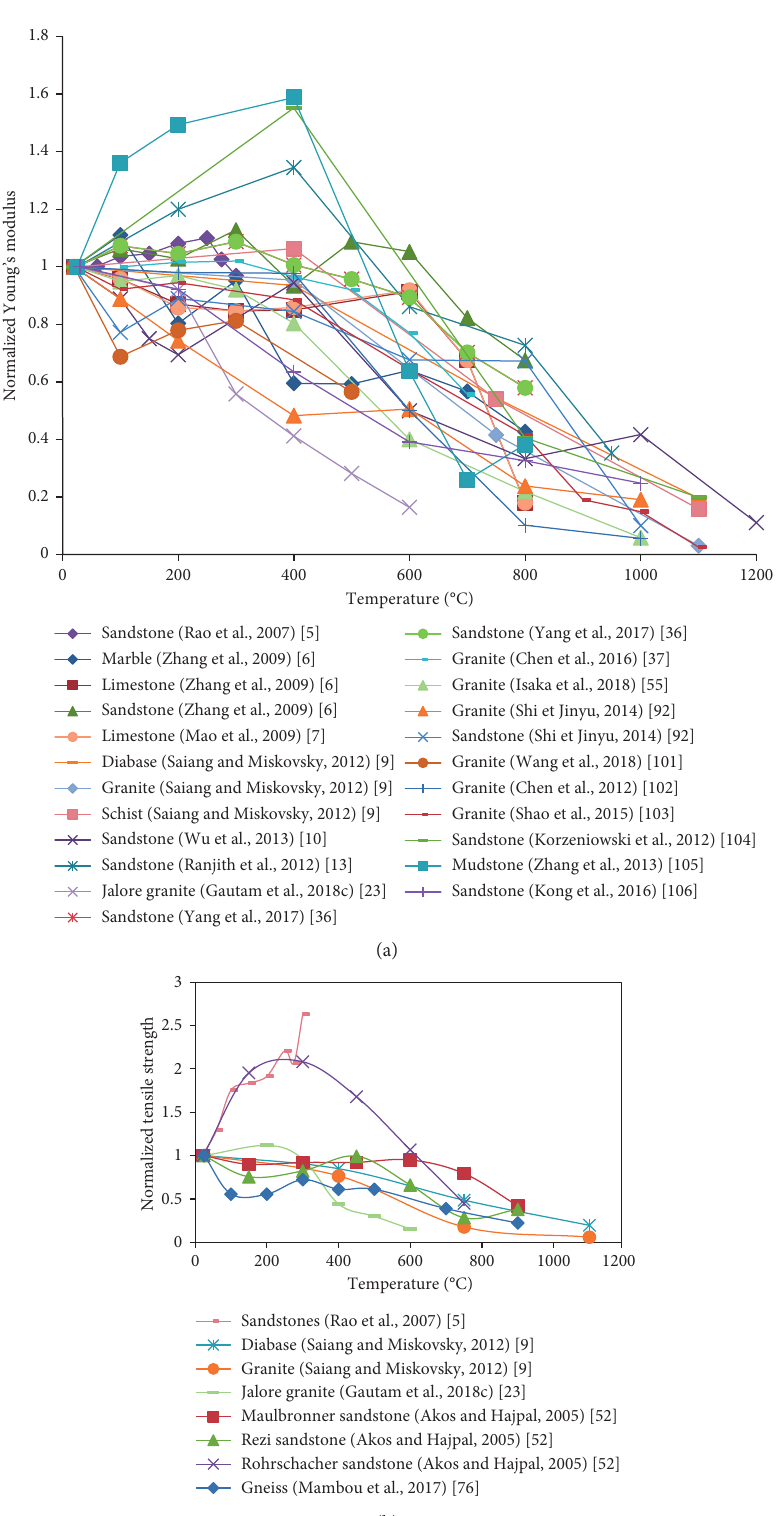
Figure 8: (a) Normalized compressive strength of certain rocks in relation to temperature. (b) Normalized tensile strength of certain rocks as function of